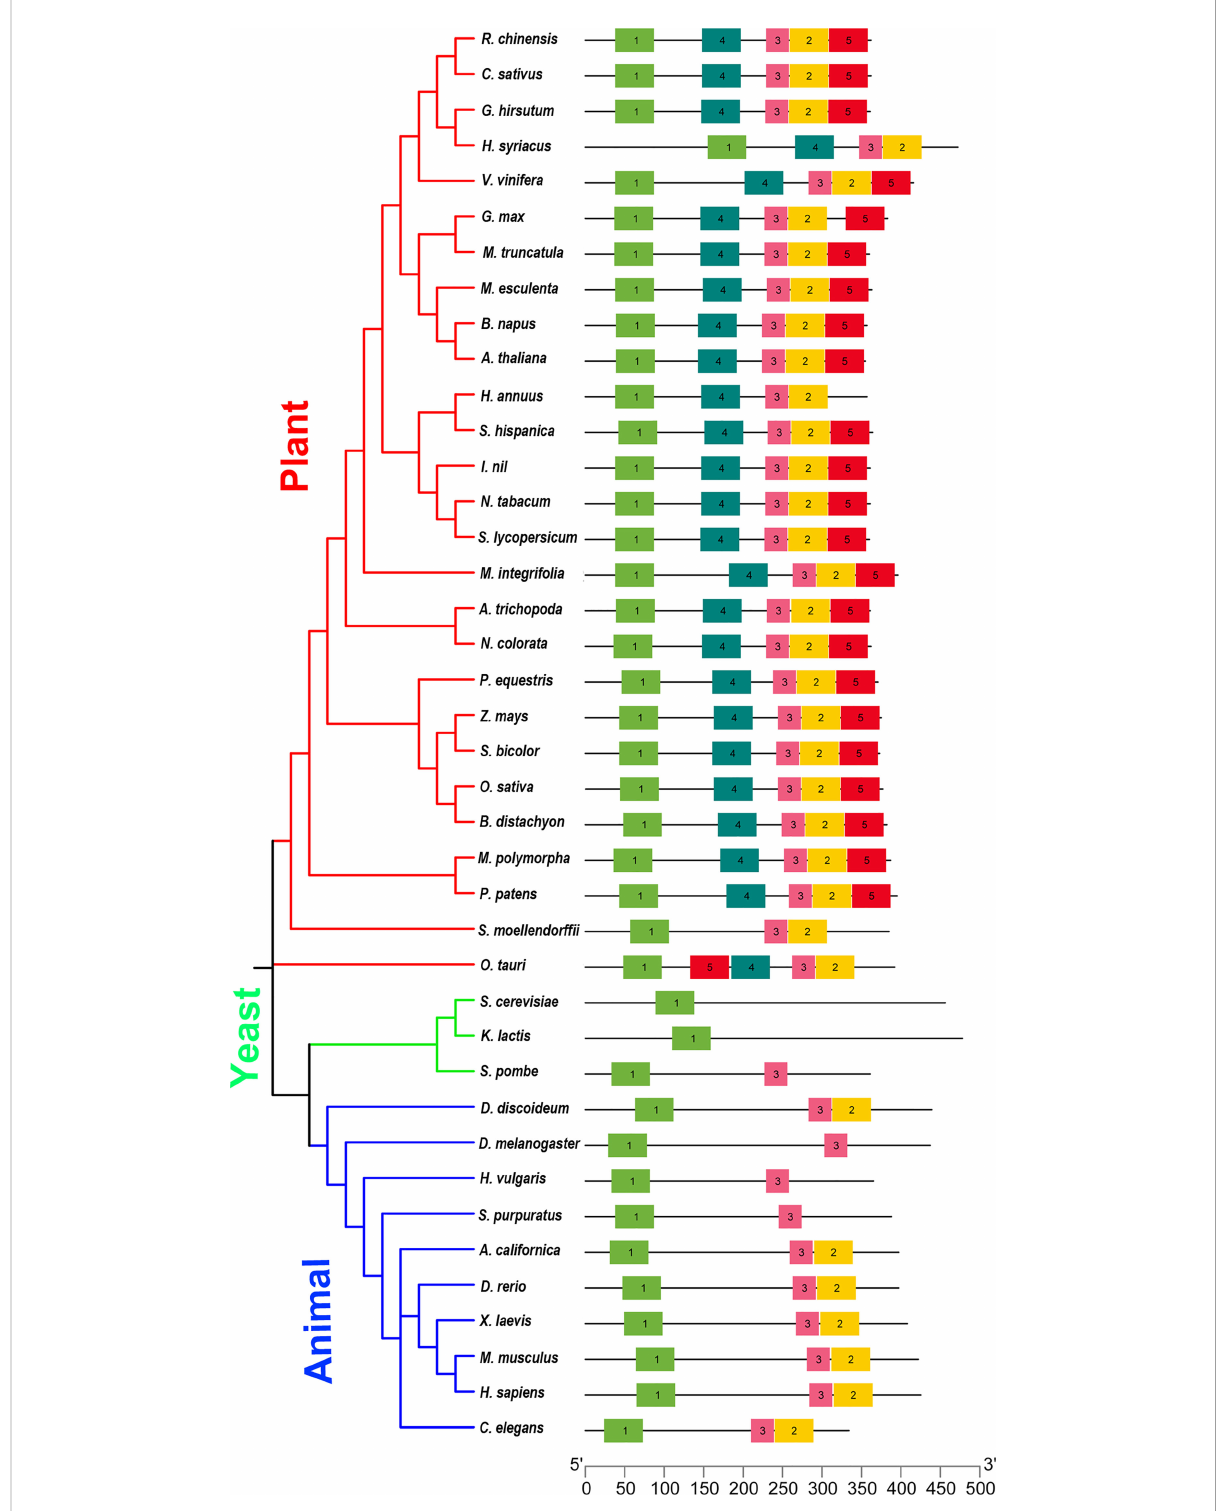
FIGURE 1 The phylogeny and conserved motif analysis and classi fi ed into three groups: plant, yeast, and animal. ELP4 protein motif composition is represented by distinct colored boxes with appropriate motif numbers and fi gure legends at the